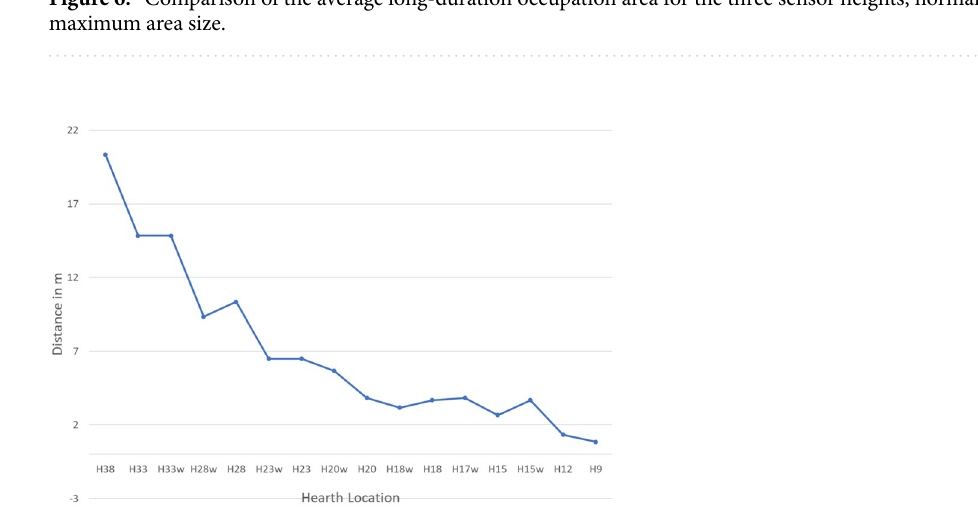
Figure 7. Average distance between hearth location and long-duration occupation